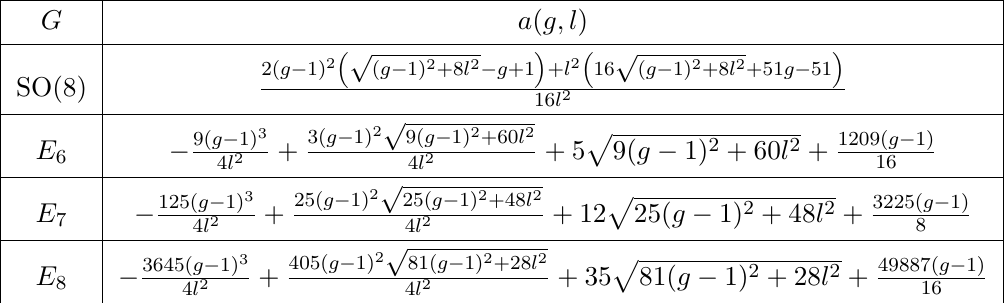
Table 4 . Value of a depending on the genus g and the U(1) (cid:13)ux l on